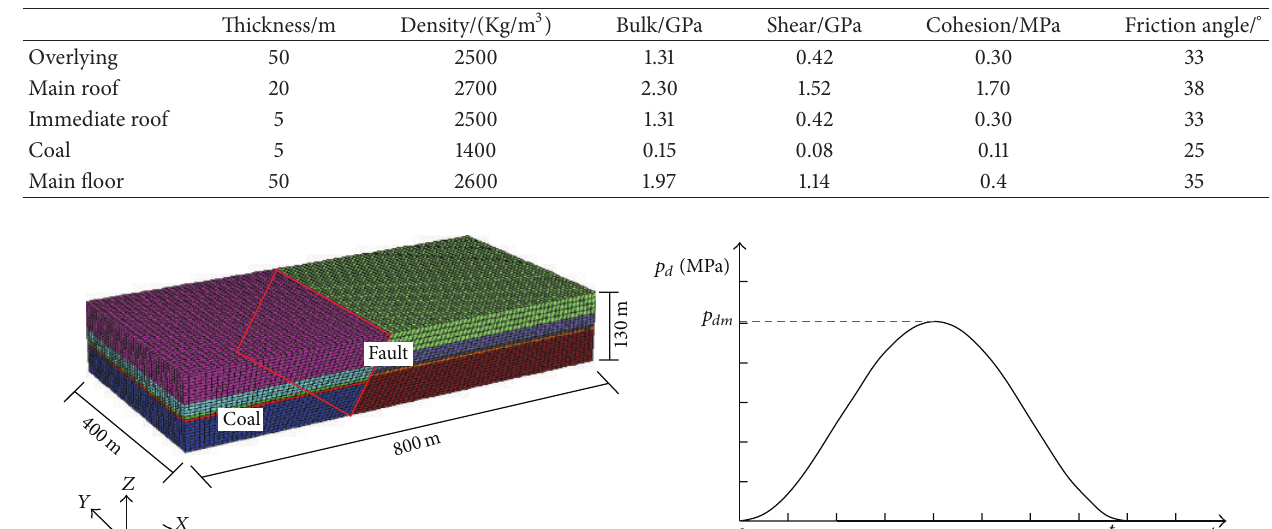
Table 1: Property parameters of the model.